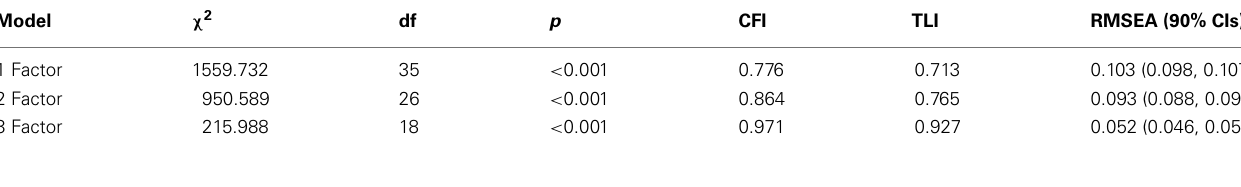
Table 2 | Exploratory factor analysis model fit statistics ( N =